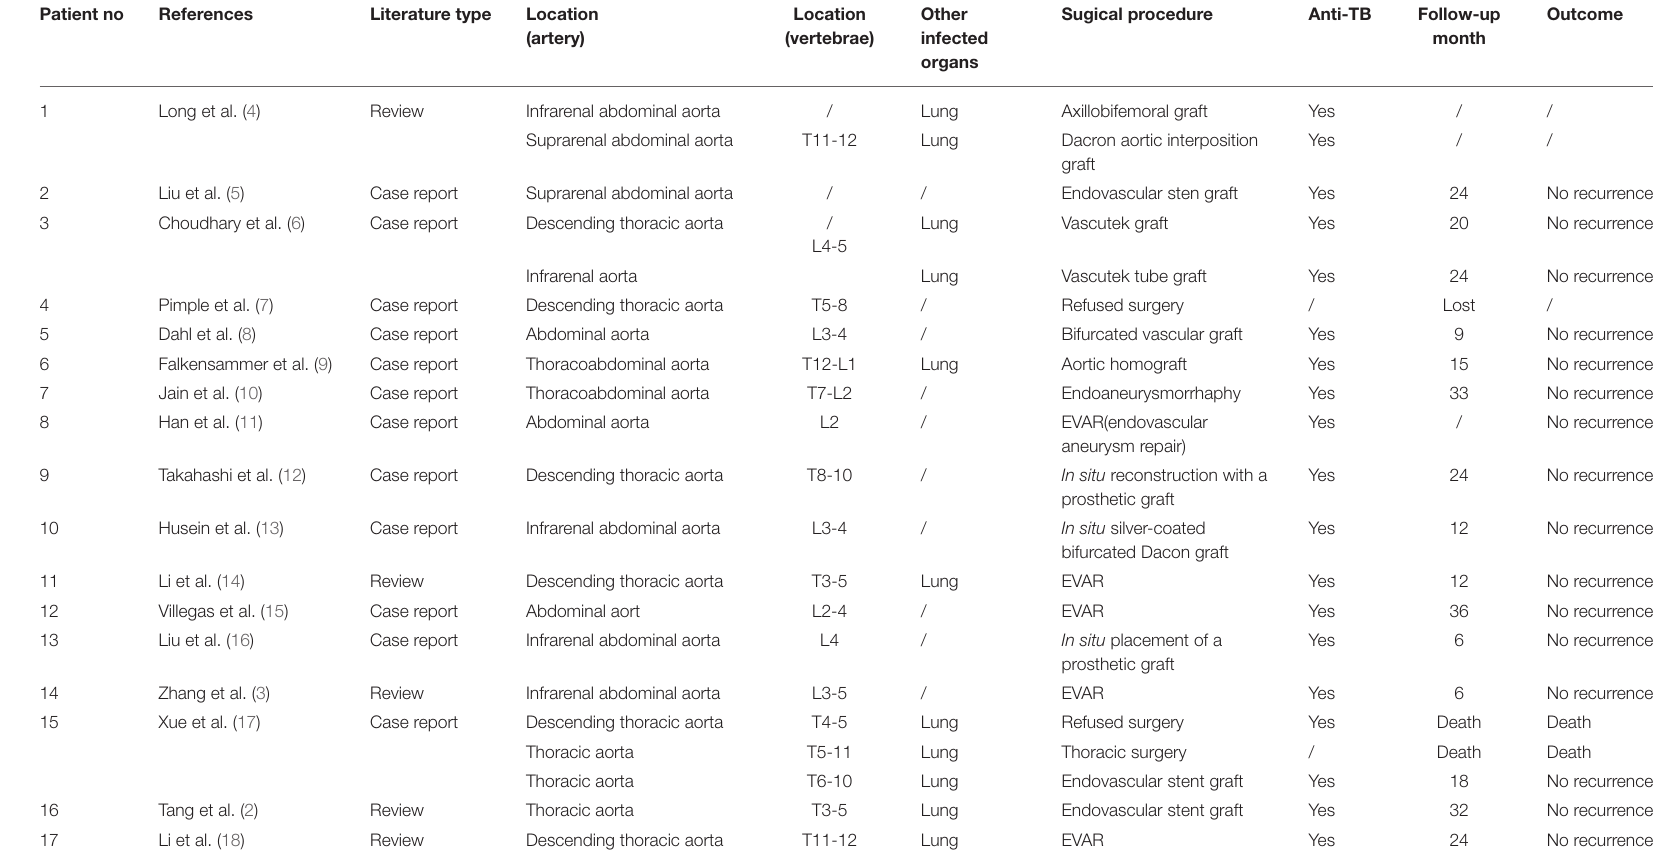
TABLE 1 | Review of literature about tuberculous pseudoaneurysm associated with vertebral tuberculosis. Patient